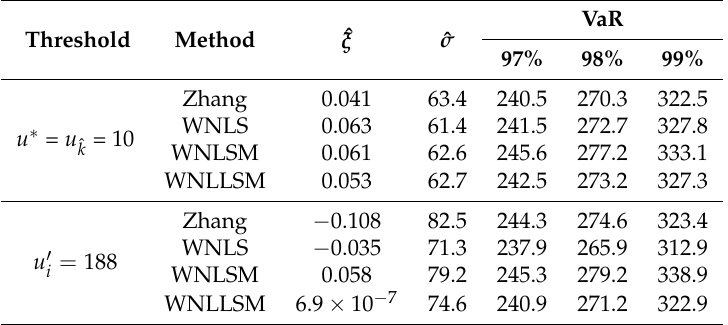
Table 3. Threshold selection and estimation results using Beijing’s daily PM2.5